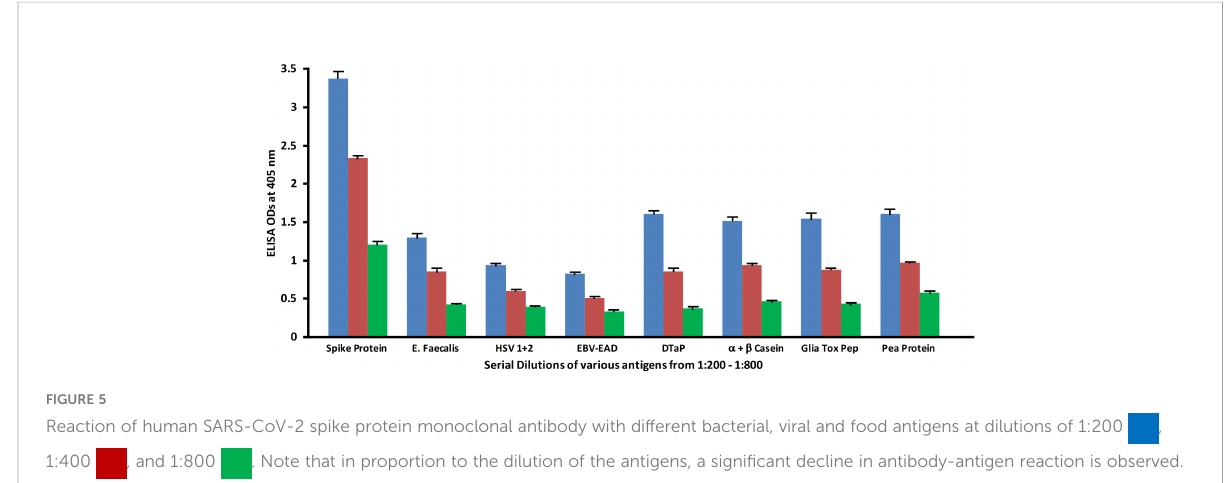
Summary results of the reaction of sera containing low or high levels of IgG antibodies against EBV-EAD, HSV 1 + 2 and HHV-6 with SARS-CoV-2 spike protein are shown in Figure 8. Compared to the reaction of 24 sera with low levels (negative) of IgG antibody against EBV-EAD, HSV 1 + 2 and HHV-6, the reaction of 24 sera containing high levels of antibodies against these viral antigens with SARS-CoV-2 spike protein resulted in higher ELISA ODs with p values of 0.052, 0.028 and 0.006 respectively for EBV-EAD, HSV 1 + 2, and HHV-6.